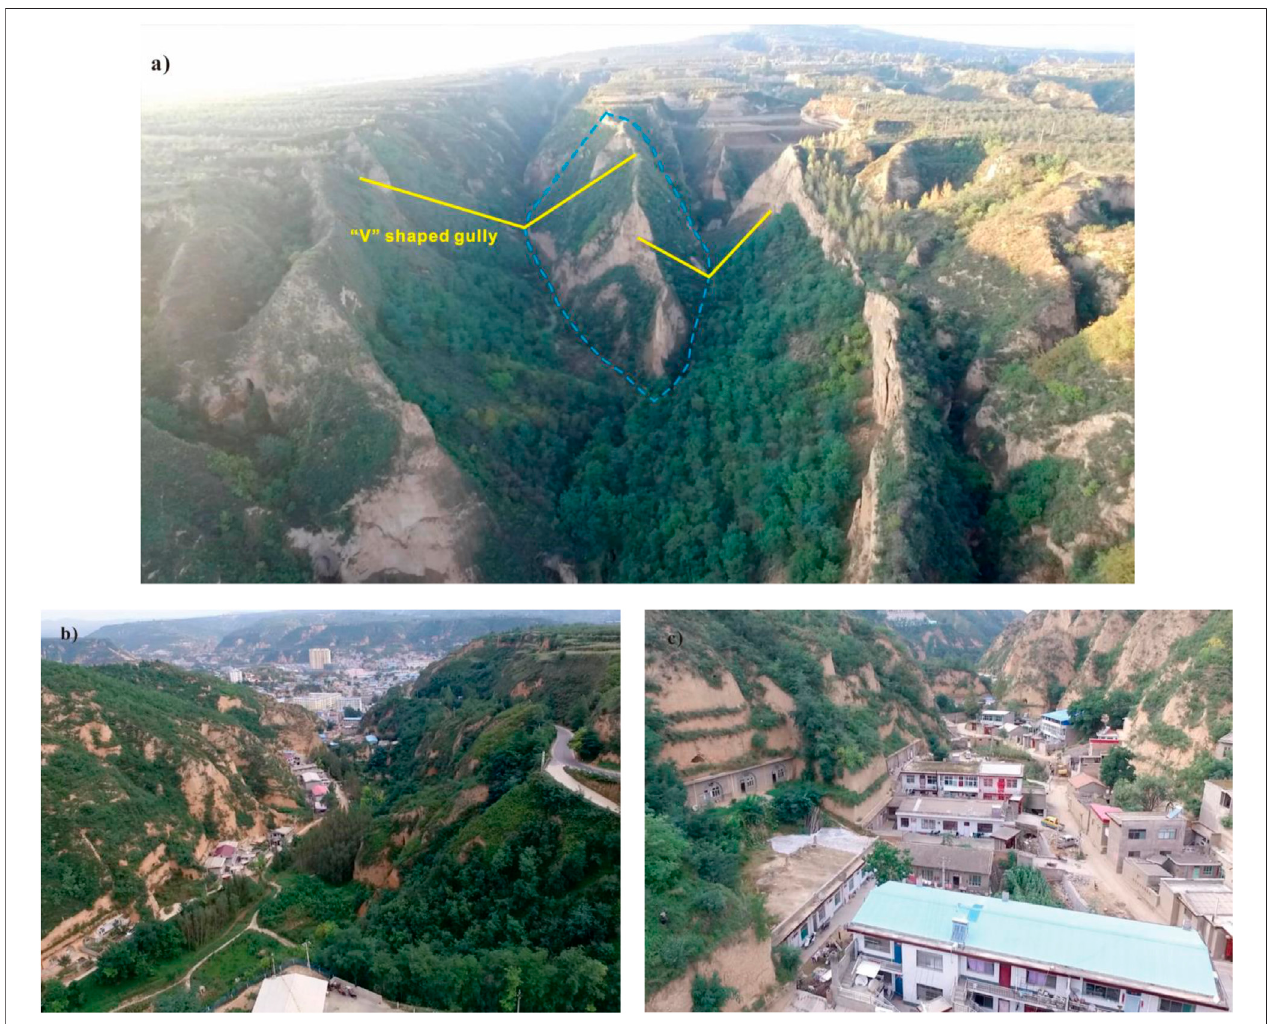
FIGURE3| PhotographsshowingthetopographyofdifferentpartsoftheChengbeiGully: (A) thesteepgullyontheuppersection, (B) therelativelywideandgentle channel of the middle section, and (C) the settlement constructed on the lower section of the gully.